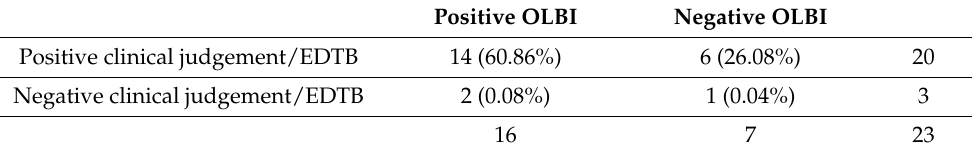
Table 8. Distribution of burnout diagnoses for general practitioners (GPs) ( N , %). Positive OLBI Negative OLBI